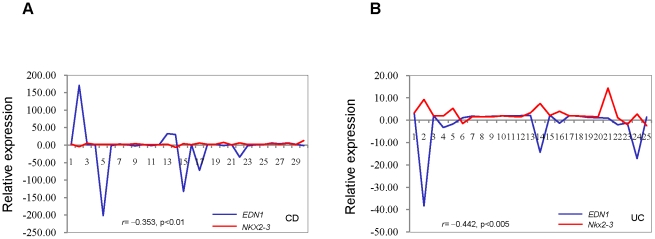
The correlation between the expression levels of NKX2-3 and EDN1 in intestinal tissues from IBD patients.(A) The correlation between the expression levels of NKX2-3 and EDN1 in diseased intestinal tissues from 30 CD patients. RT-PCR was carried out on surgically excised intestinal tissues. The RT-PCR product bands on the photograph were scanned by densitometry. RT-PCR results were normalized by GAPDH in every patient. Correlation coefficient (r) and p value are shown. (B) The correlation between the expression levels of NKX2-3 and EDN1 in diseased intestinal tissues from 25 UC patients.